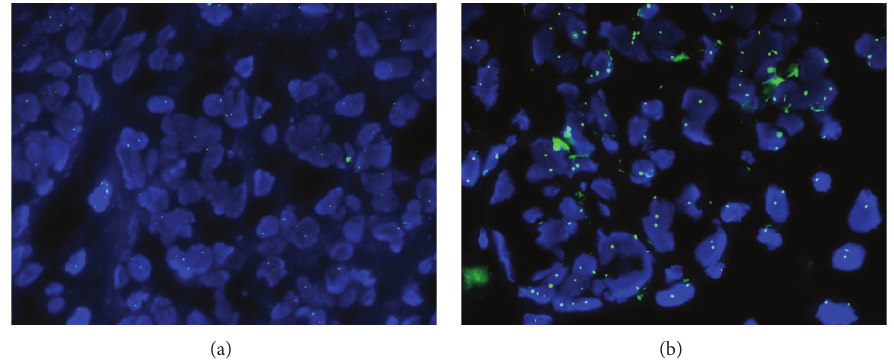
Figure8:Interphasefluorescentinsituhybridization(FISH)imageshowingDAPIstainedinthevesicle-likestemvilliandthechorioangioma. ThenucleiwerehybridizedwithagreenX-centromere(DXZ1)andaredY-centromereprobe(DYZ3).OnlygreenX-centromere(DXZ1)probe were found within a single cell.